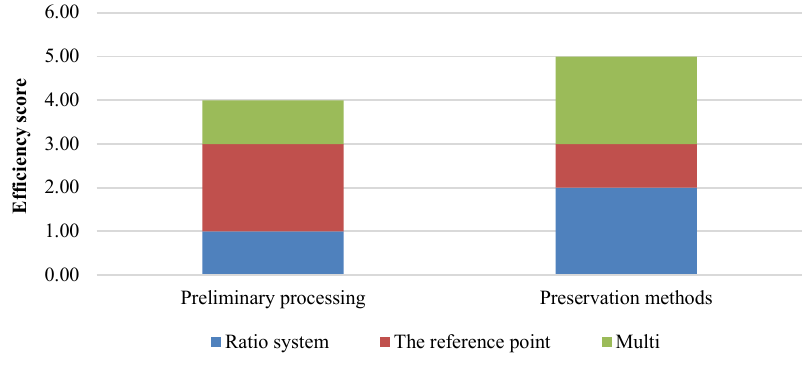
Fig. 4. The results of MULTIMOORA